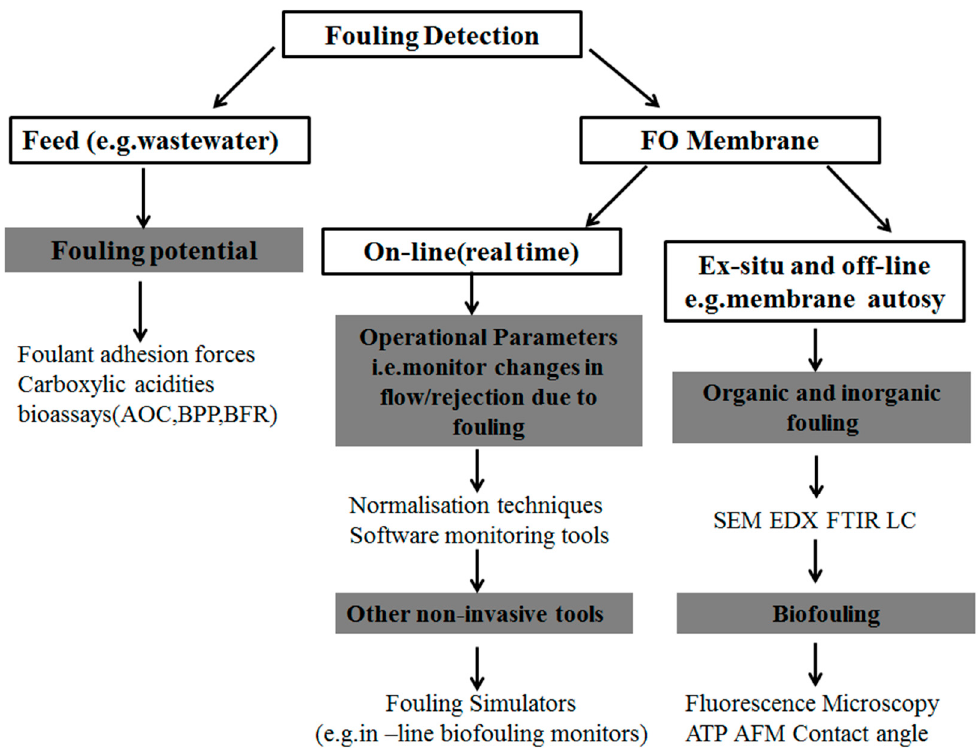
Figure 3. Methods used in literature to detect the fouling potential of the feed or monitor/analyse fouling on the FO membrane.